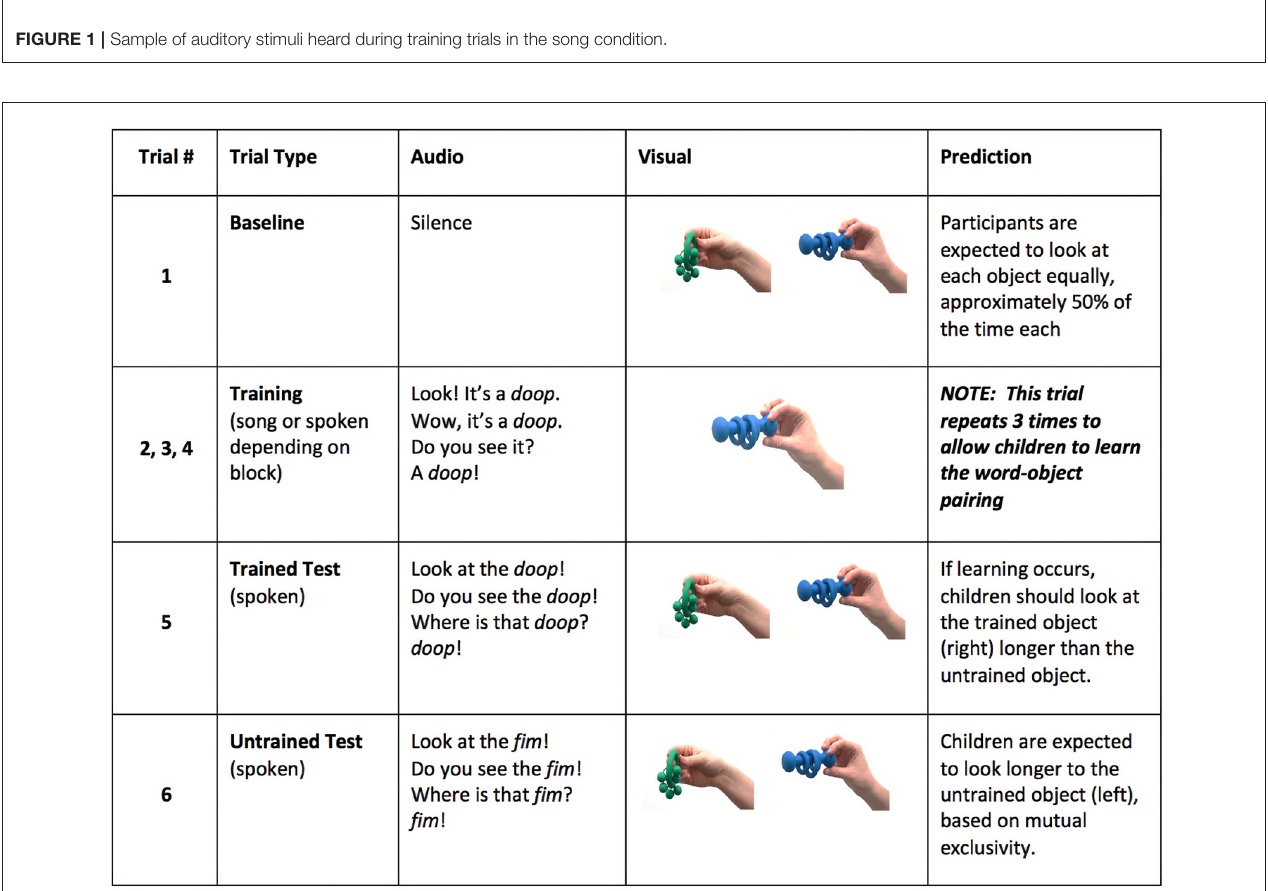
FIGURE 2 | An example of the presentation of stimuli in a